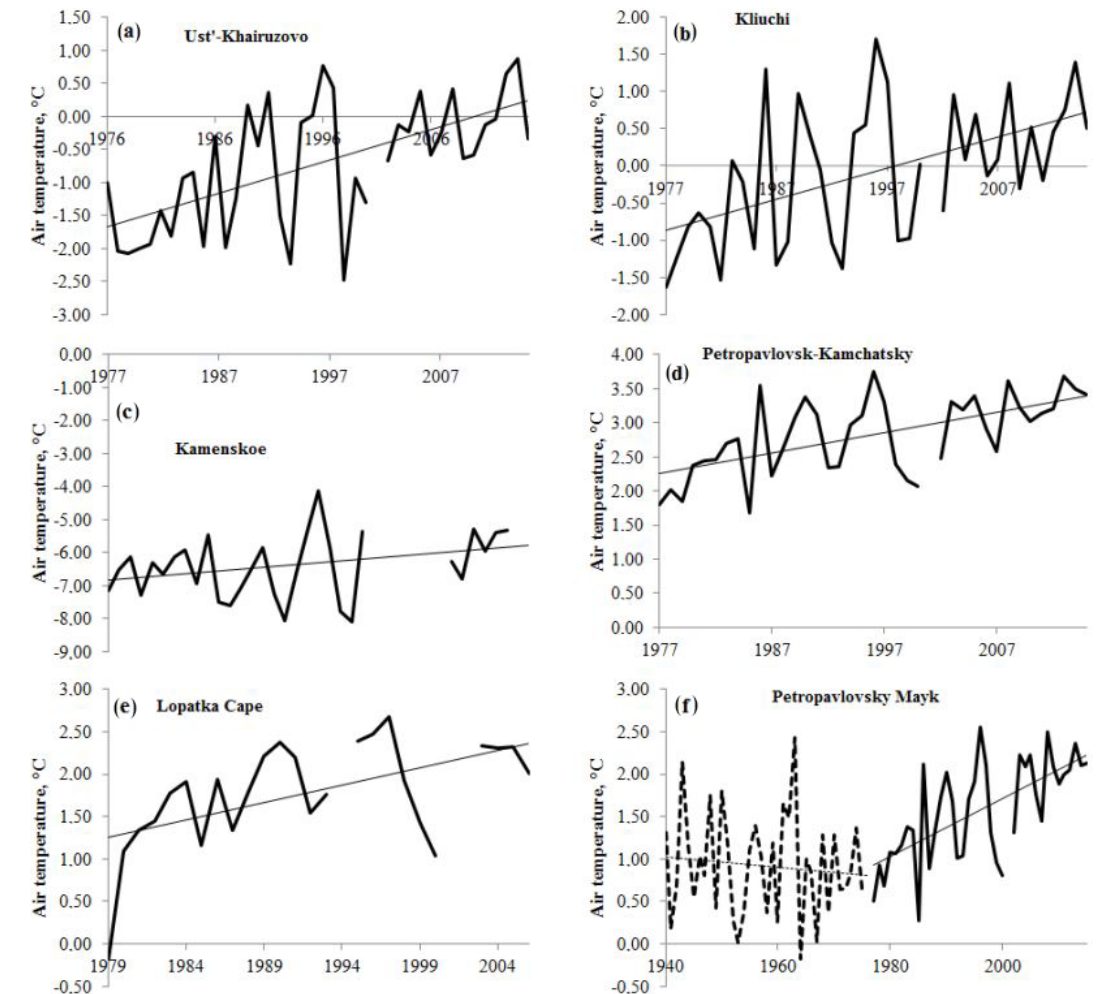
Figure 2. Trends in air temperature change in the western coast (Ust’-Khairuzovo station, a ), central part (Kliuchu station , b ), northern (continental) part (Kamenskoe station, c ), eastern coast (Petropavlovsk-Kamchatsky station, d ), Petropavlovky Mayk station, (f) , and the very south of the peninsula (Lopatka Cape station, e ), in the Kamchatsky